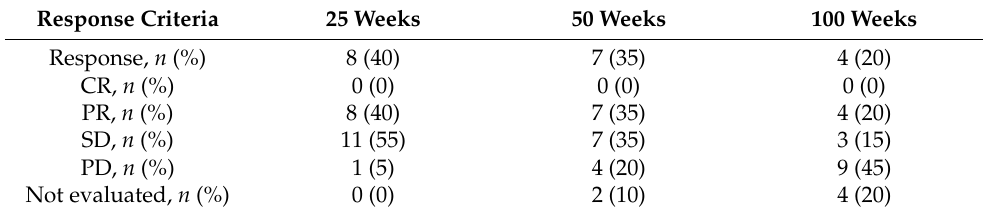
Table 4. Long-term outcomes after PRRT based on RECIST in the 20